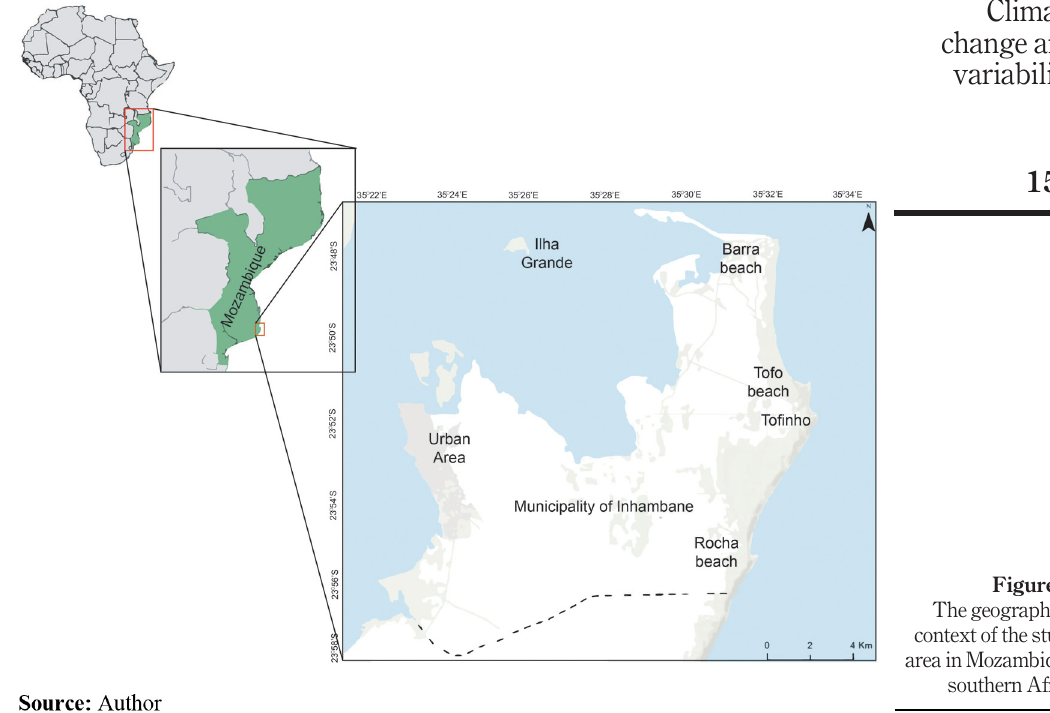
Figure 1. The geographical context of the study area in Mozambique, southern